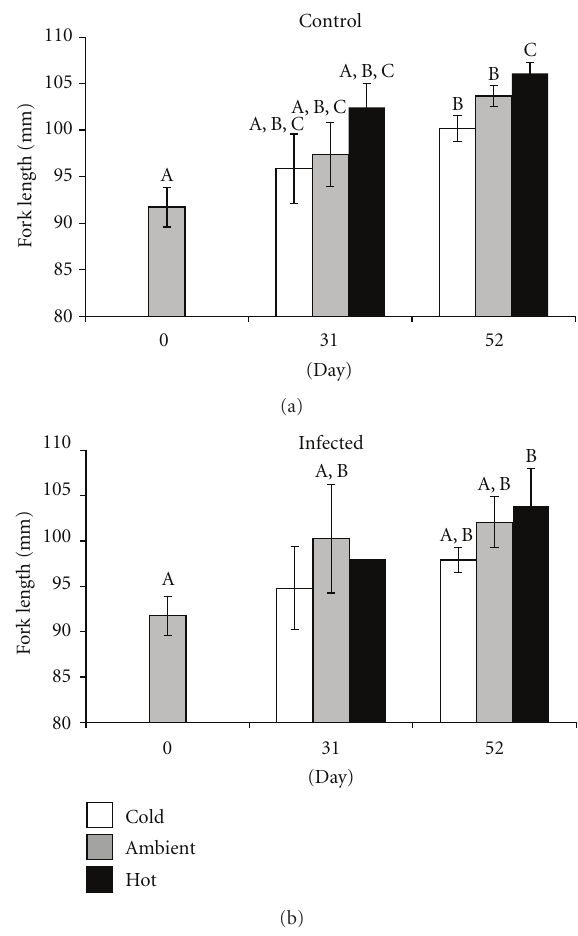
Figure 5: Growth rates of “spring” young-of-the-year herring over the course of the experiment under variable temperature conditions: cold (9.5 ◦ C), ambient (12.0 ◦ C), and hot (15.0 ◦ C). Di ff erent letters represent statistical di ff erentiation. Lack of letters indicates no statistical di ff erentiation. Low sample size of infected fish on day 31 precludes statistical